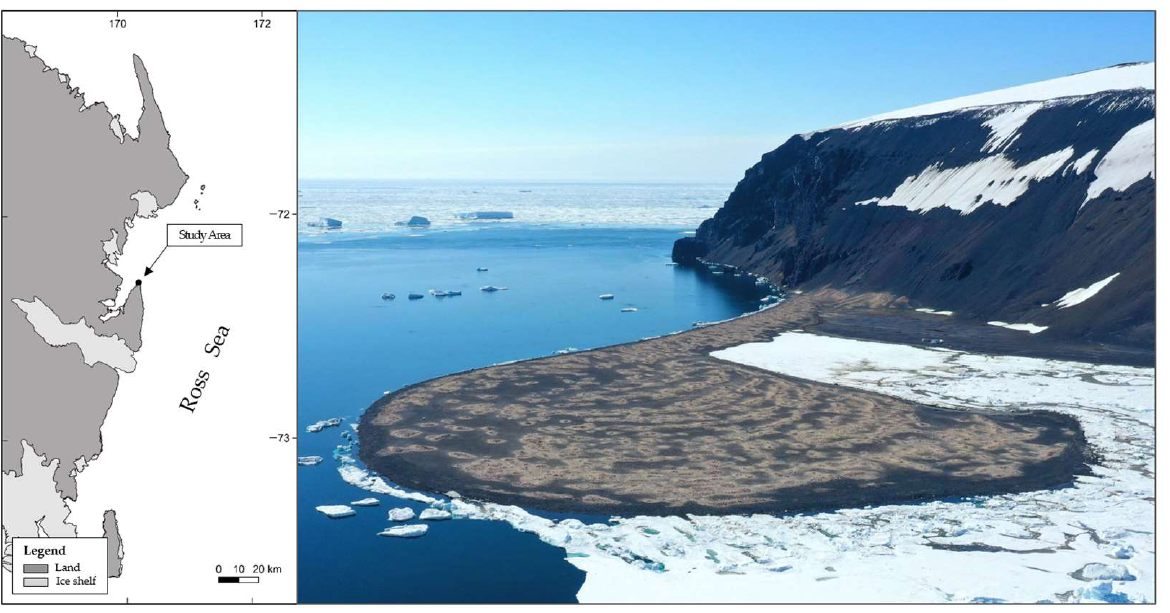
Figure 2. Location of Study area (Cape Hallett) in northern Victoria Land, Ross Sea, Antarctica.